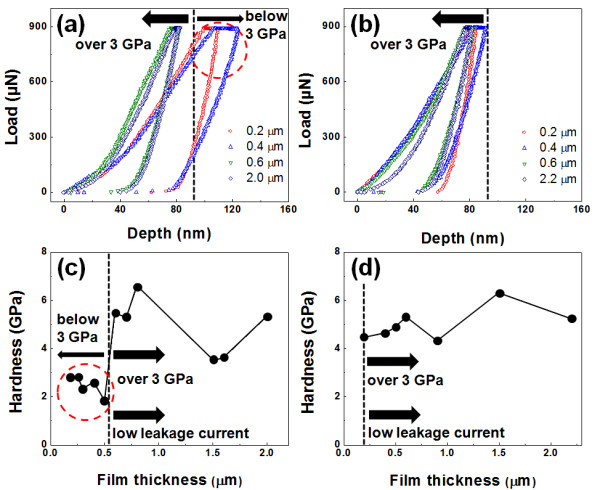
Load–displacement curve and thickness dependence of surface hardness of BaTiO3films.P-h curves of BaTiO3 films on (a) Cu and (b) SUS substrates for a load force of 900 μN and the thickness dependence of surface hardness of the films on (c) Cu and (d) SUS substrates.